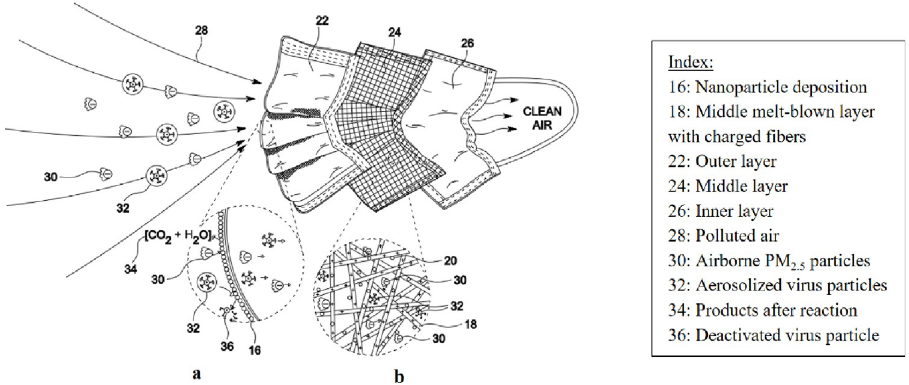
Fig 13. The nanoparticle coated mask is capturing and oxidizing particulate matter and virus particles with the aid of the nanoparticles embedded in its layers.